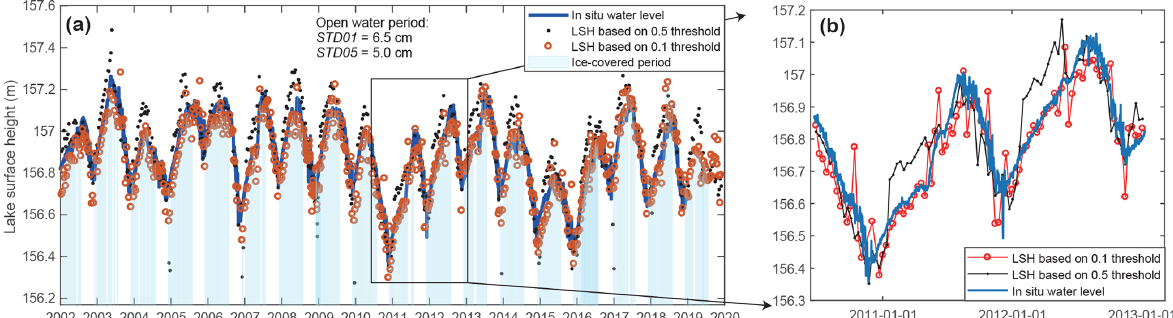
Figure 9. Comparison between LSH estimates using different thresholds in GSL. Panel (a) shows time series for altimetric LSH based on different thresholds and in situ water levels. Panel (b) is a magnified view for the LSH time series during 2011–2013. The blue curve denotes in situ water levels, red dots denote LSH based on a 0.1 threshold, black dots denote LSH based on a 0.5 threshold, and light blue shaded areas denote ice-covered